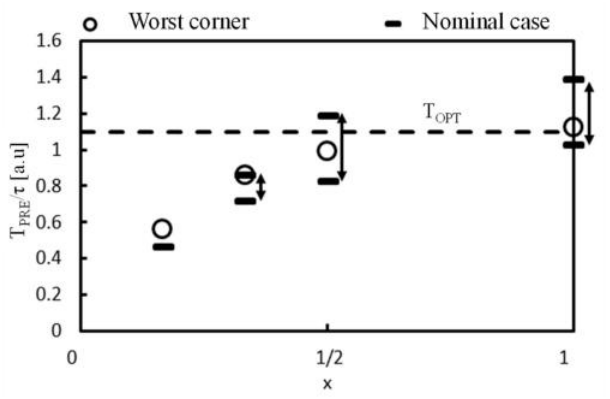
Figure 10. Optimum T PRE vs. x under the nominal and worst